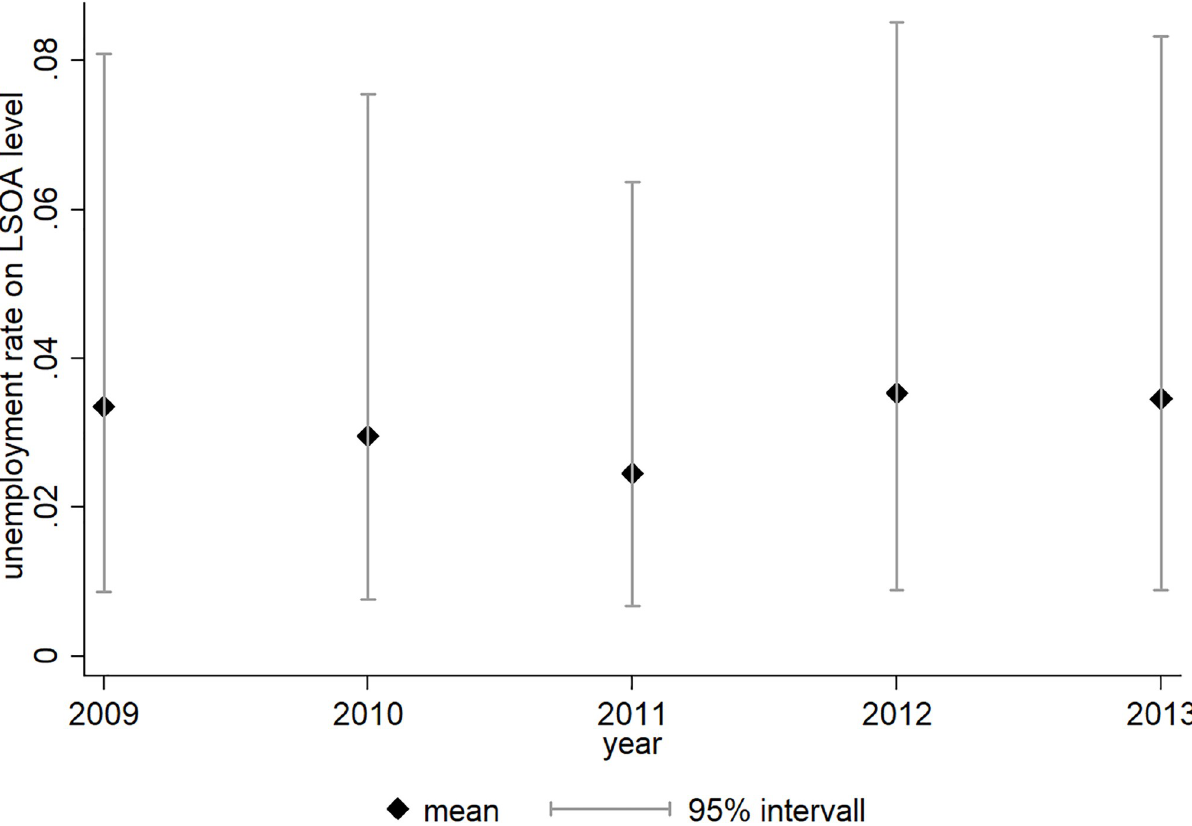
Fig 1. Annual distribution of the unemployment rate at LSOA-level. Source : DfT Accessibility Statistics 2013. The figure shows the annual distribution of the unemployment rate on LSOA level.